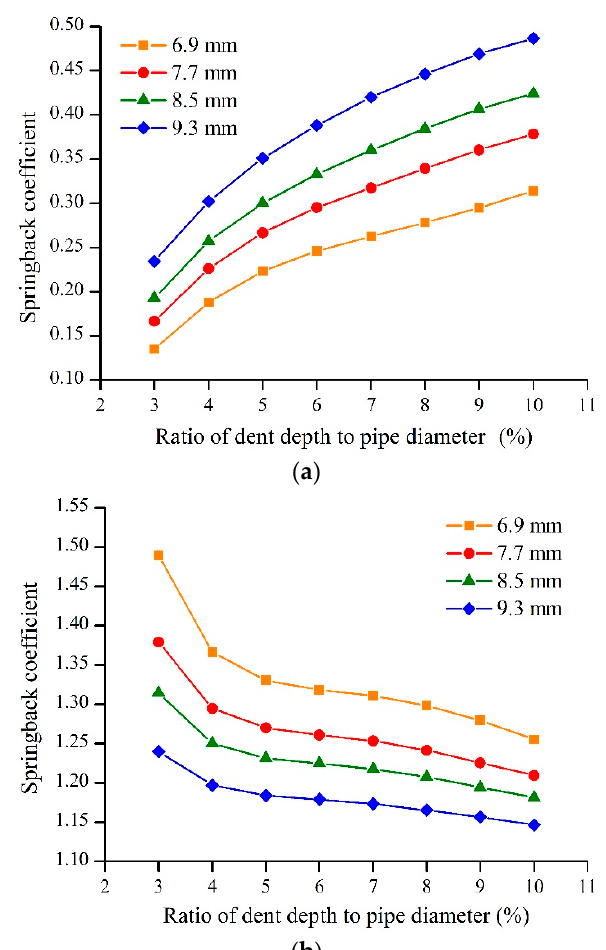
Figure 6. Dent depth and springback coefficient with variation of the wall thicknesses during denting: ( a ) pressurization; ( b ) de-pressurization.